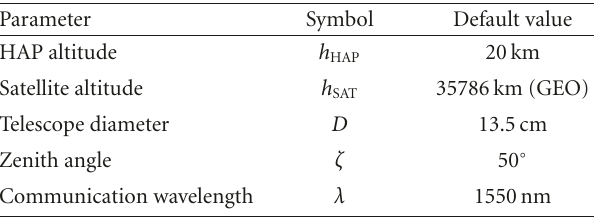
Table 1: Typical parameter set for the satellite-to-HAP communi- cation scenario.